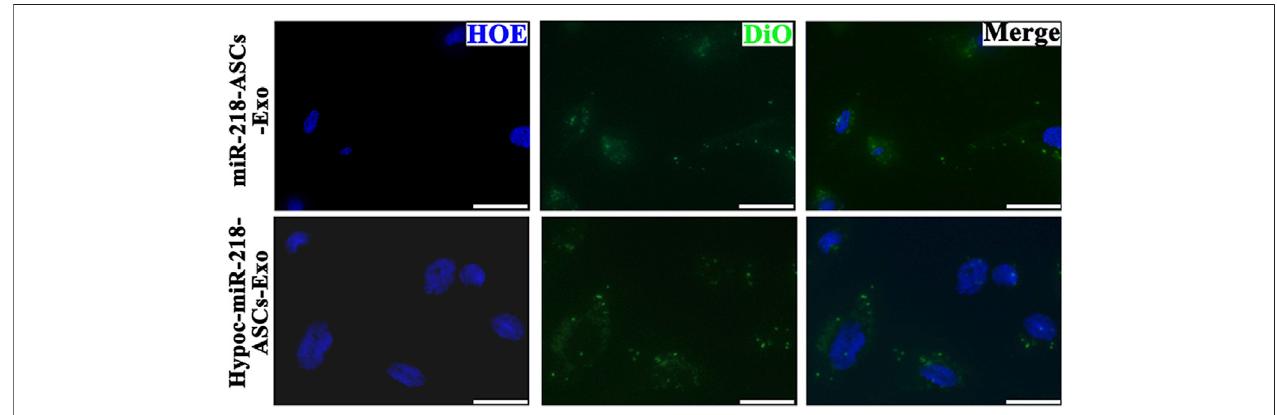
FIGURE 6 | Confocal images of DiO-labeled exosomes (green) and nuclei (blue) were monitored by microscope in two groups (scale bars = 10 μ m).